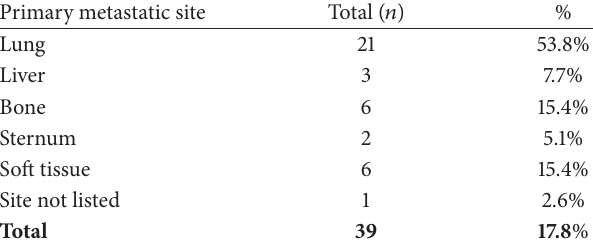
Table 3: Primary metastasis.